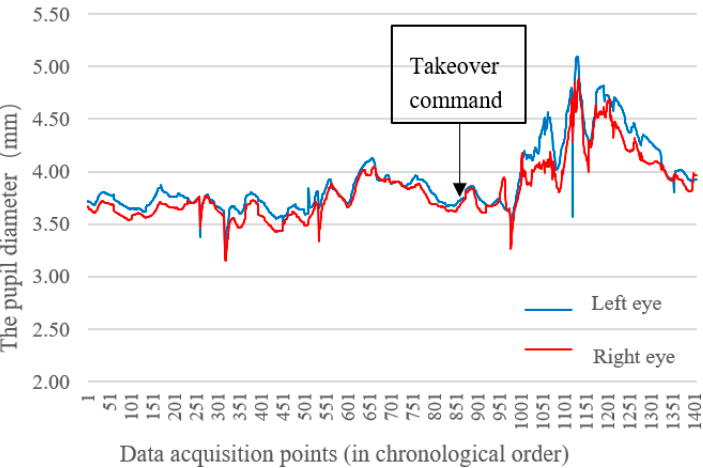
Figure 10. Change of pupil diameter of both eyes during takeover process in the most-critical scenario without MR.